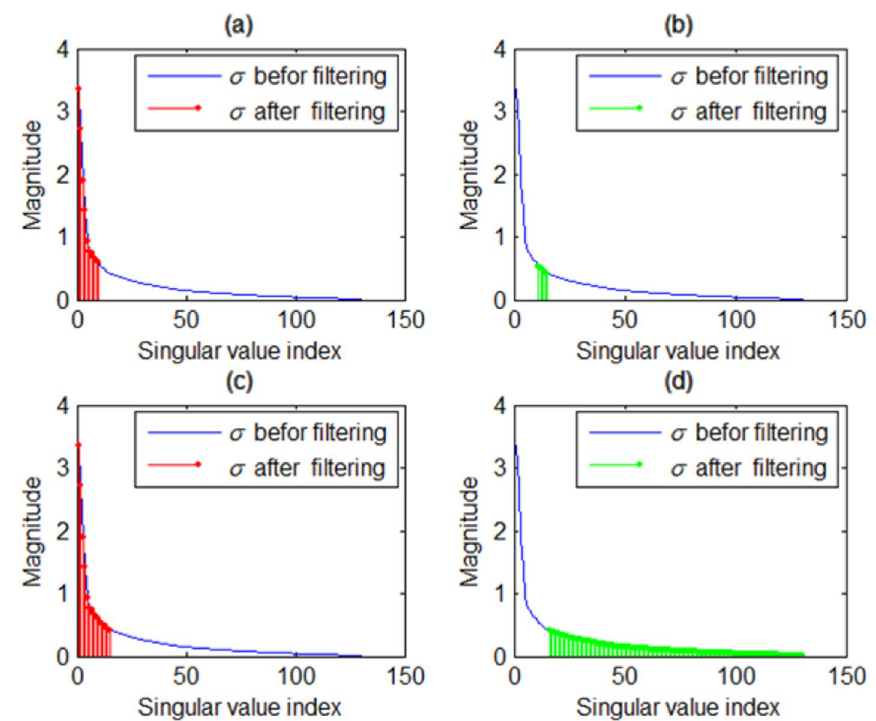
Fig. 6 Singular values of the frequency Spectra of Fig. 4. The blue line represents whole sin- gular values. The red and green lines represent the selected singular values to be used in reconstruction